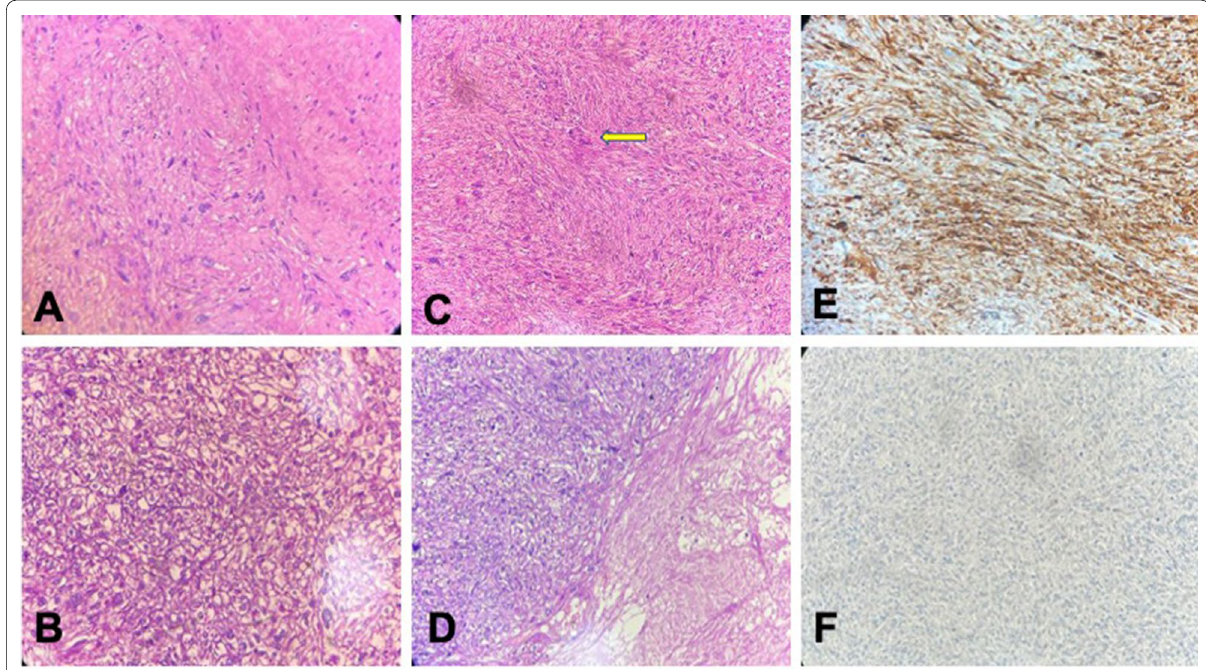
Fig. 2 Malignant spindle cell tumor arranged in fascicular pattern, A (marked). D Areas of nuclear pleomorphism, necrosis and hyalinization. E Desmin stain positive. F S-100 stain